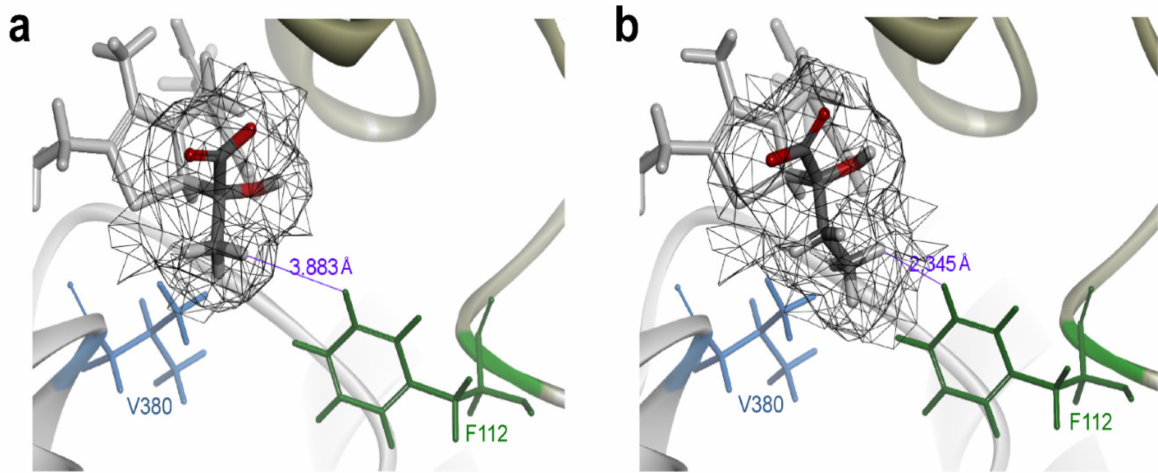
Figure 3. Potential residues for directed evolution of pyruvate oxidase (PoxB) in selectivity for pyruvate. ( a ) Docking simulation of pyruvate covalent conjugate into the substrate-binding pocket. ( b ) Docking simulation of 2-OBA covalent conjugate into the substrate-binding pocket. Residues F112 and V380 at the entrance of the substrate-binding pocket were